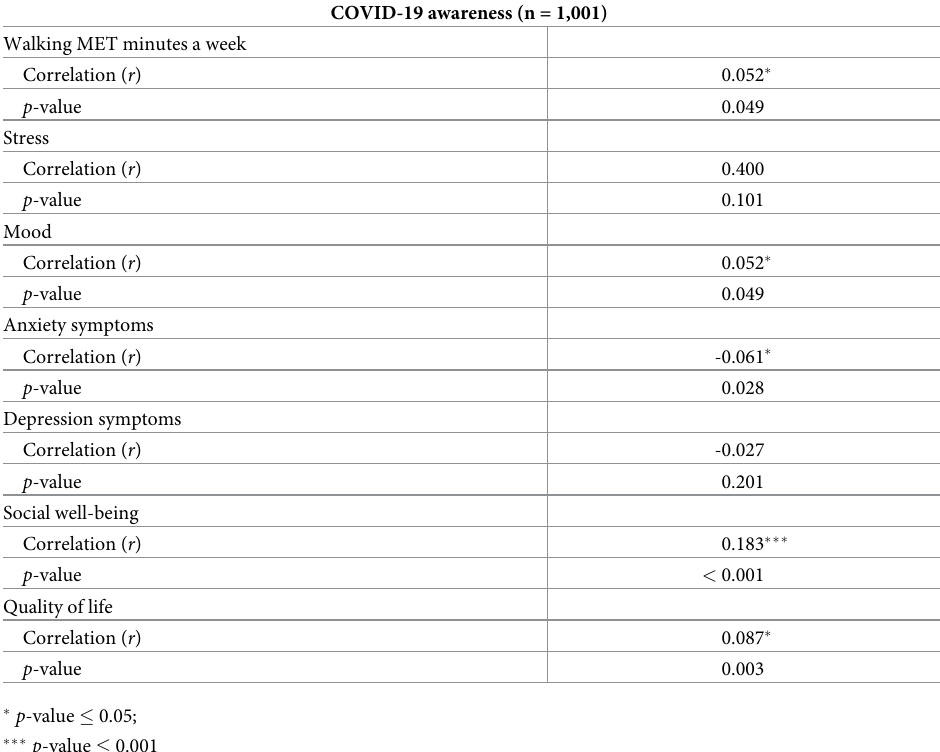
Table 4. Association between COVID-19 awareness and physical activity, stress, mood, symptoms of anxiety and depression, social well-being, and quality of